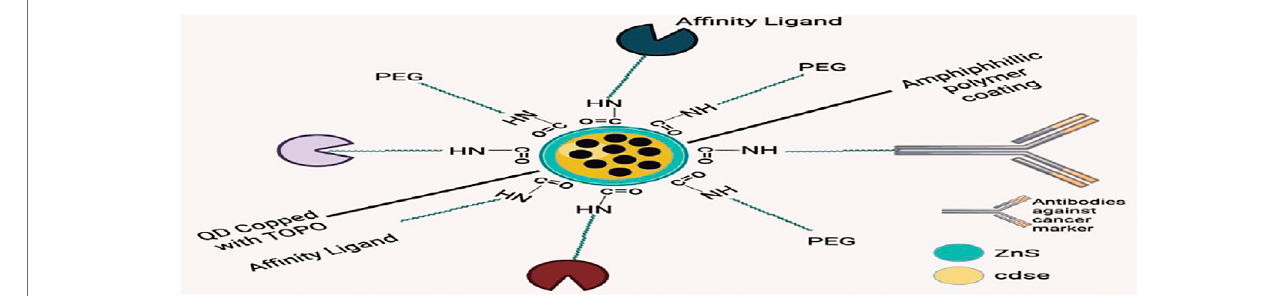
FIGURE 8 | Bioconjugates of quantum dots.